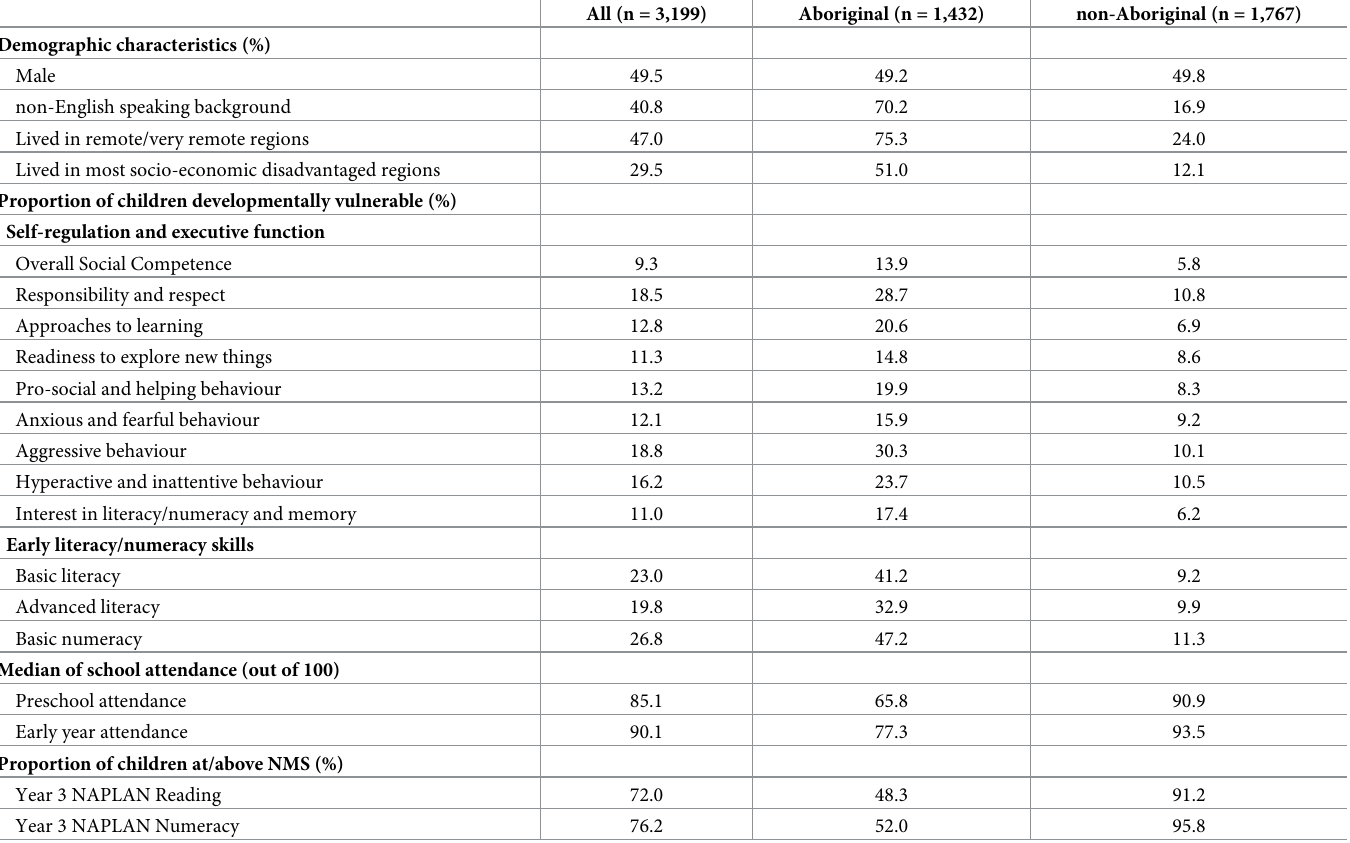
Table 1. Demographic characteristics of NT children who received AEDC assessments, attended public school (from preschool to Year 3) and participated in Year 3 NAPLAN